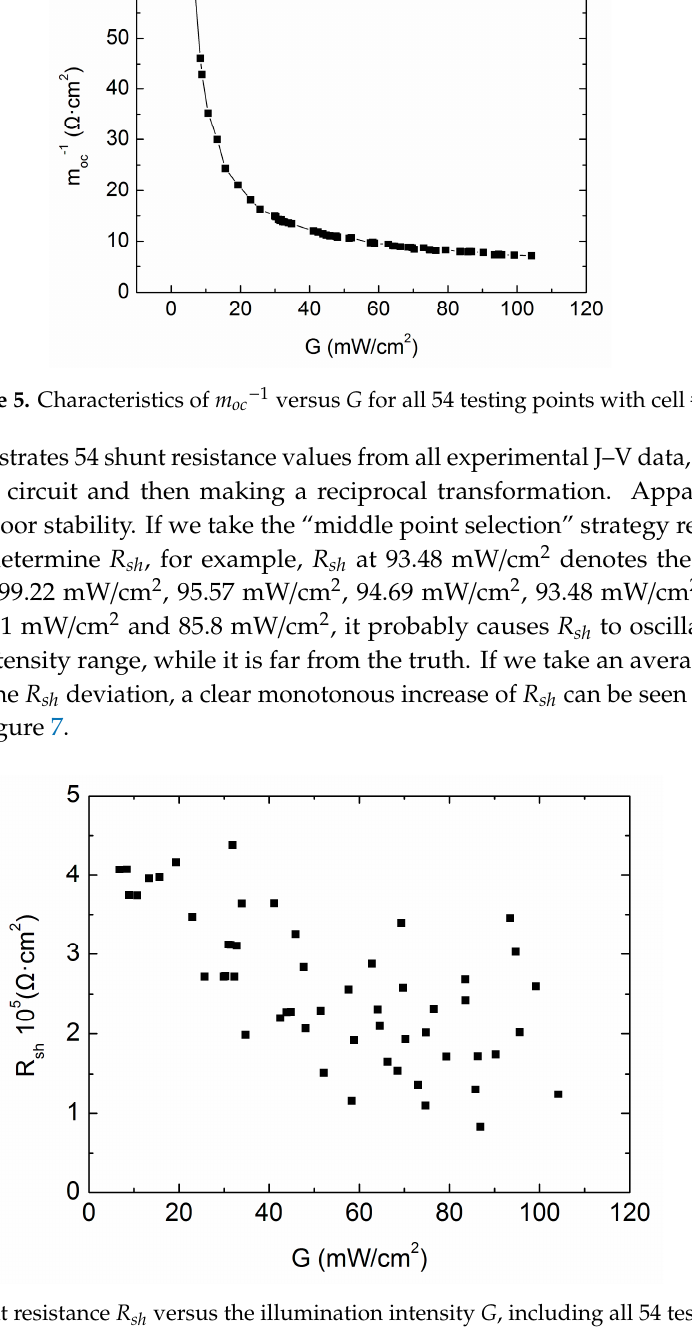
Figure 7. Intensity G versus J 0 and R sh under low intensity illumination condition for cell #1. Figure 7 shows the variations of the shunt resistance R sh and the reverse saturation current density J 0 with low solar irradiance. R sh exceeds 100,000 Ω ·cm − 2 , the defect caused current model should be employed to explain the variations, R sh is so high that the cell is well designed. With a decreased light intensity, the photo-generated carriers and hence the captured carriers also decreases, indicating the increase of R sh [22]. The reverse saturation current density relies on space charge recombination, bulk recombination, and surface recombination. The principles are as follows: (1).if the light intensity is low, the space charge recombination is significant, and the reverse saturation current density is large; (2). if the light intensity approaches 1 sun, the main contribution is from the bulk recombination and the surface recombination, and the corresponding current density is thus relatively low;(3) less generation of carriers causes J 0 to drop. Therefore, J 0 monotonously increases with the irradiation intensity decreasing from about 1 sun to 30 mW/cm 2 , as recombination mechanisms dominate J 0 . With the light intensity lower than 30 mW/cm 2 , principles (1) and (3) take